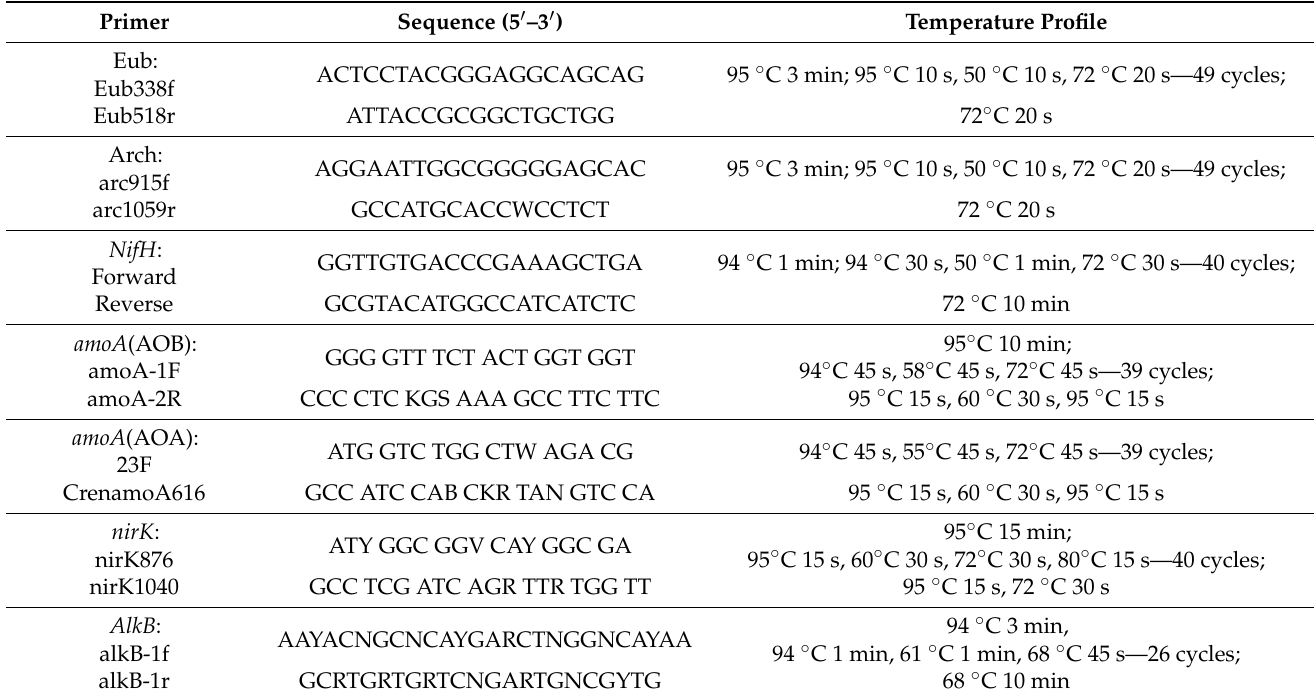
Table 4. qPCR primers and temperature conditions used to determine the presence of genes in the studied samples.